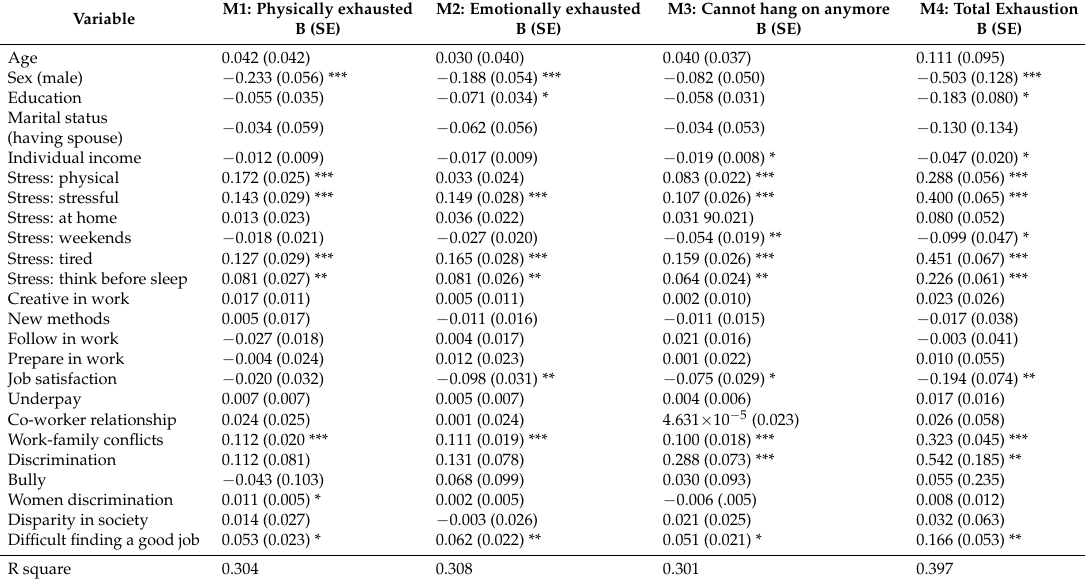
Table 3. Different exhaustion of workers and associated factors by linear